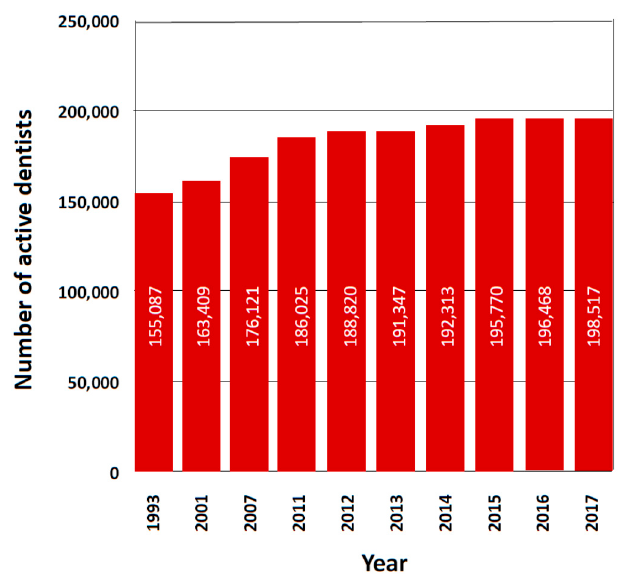
Figure 32. Number of practicing dentists in various European countries per 100,000 inhabitants in 2017 and the rate of changes in the number of dentists in 2018 compared to 2017.